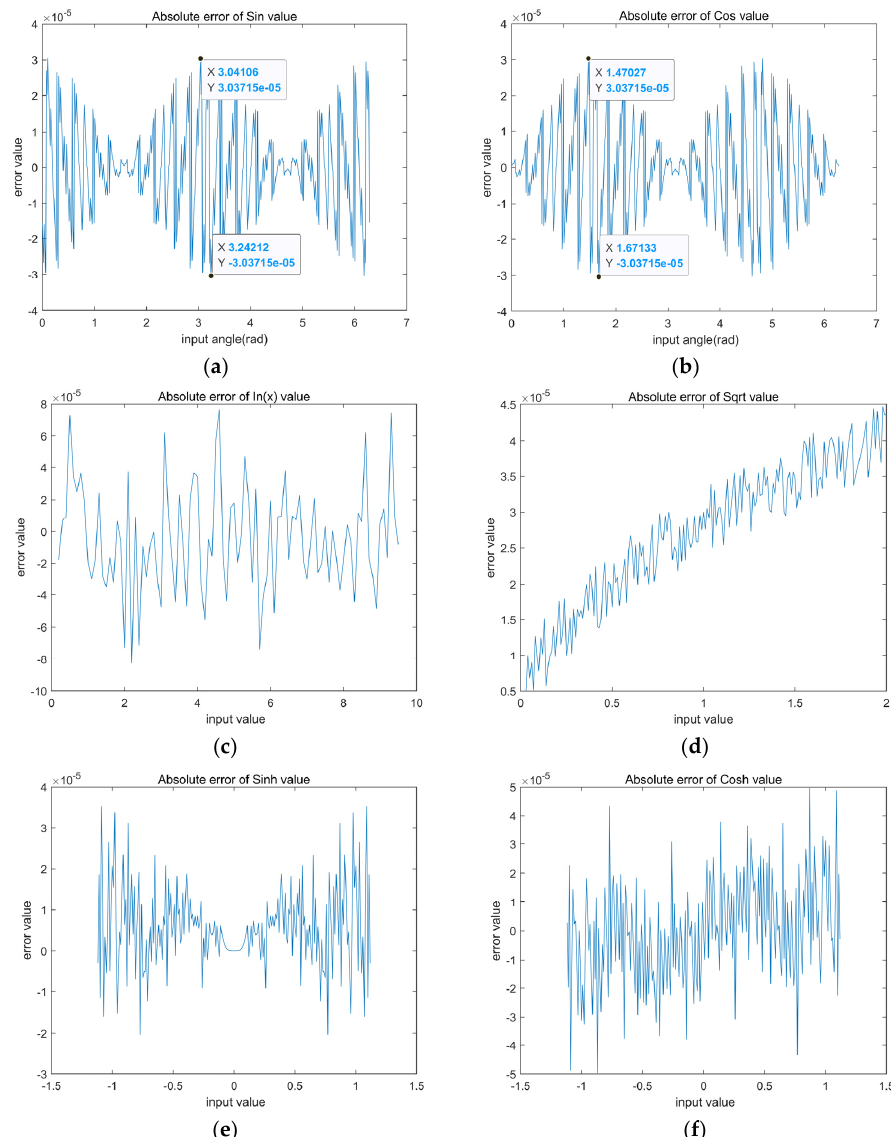
Figure 9. The various functions calculation error base on RDP-CORDIC algorithm: ( a ) Absolute error of sine signal value; ( b ) Absolute error of cosine signal value; ( c ) Absolute error of ln( x ) value; ( d ) Absolute error of sqrt value; ( e ) Absolute error of sinh value; ( f ) Absolute error of cosh value. Table 7. Time consumed for the first calculation of the sine and cosine function. CORDIC Algorithm